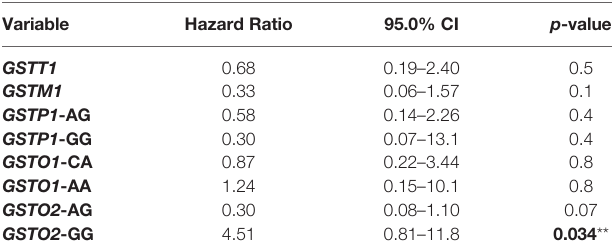
TABLE 4 | Multivariate analysis for disease-free survival (DFS) of ALL patients according to different GST genotypes. Variable